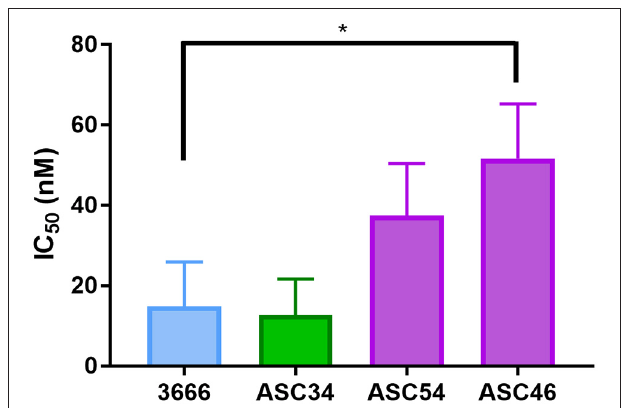
FIGURE 8 | Comparison of IC50 values for tumor ascites lines and the parental mFT line 3666. ASC34 was derived from an animal treated with NanoTalazoparib that developed ascites at 48 days. ASC54 and ASC46 were derived from animals treated with oral Talazoparib and developed ascites after 57 and 50 days of treatment, respectively. All experiments performed in triplicate. Statistical significance determined using one way ANOVA followed by Tukey’s test compared to 3666, * p <